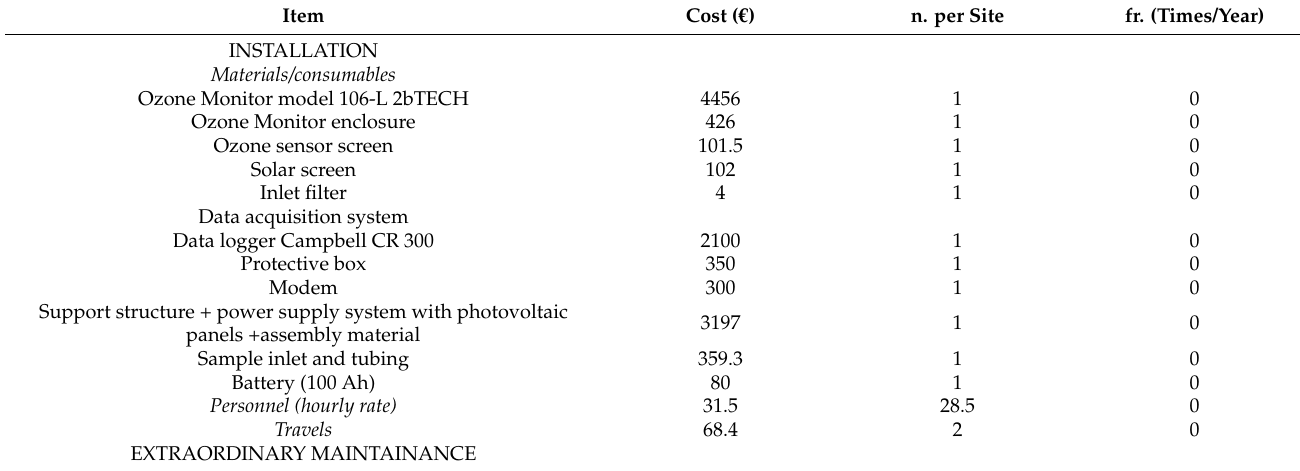
Table 4. Costs of active monitoring station items listed separately per installation, ordinary maintenance, extraordinary maintenance, and data collection for deciduous forests (DF) and evergreen Mediterranean forests (EF). fr.,